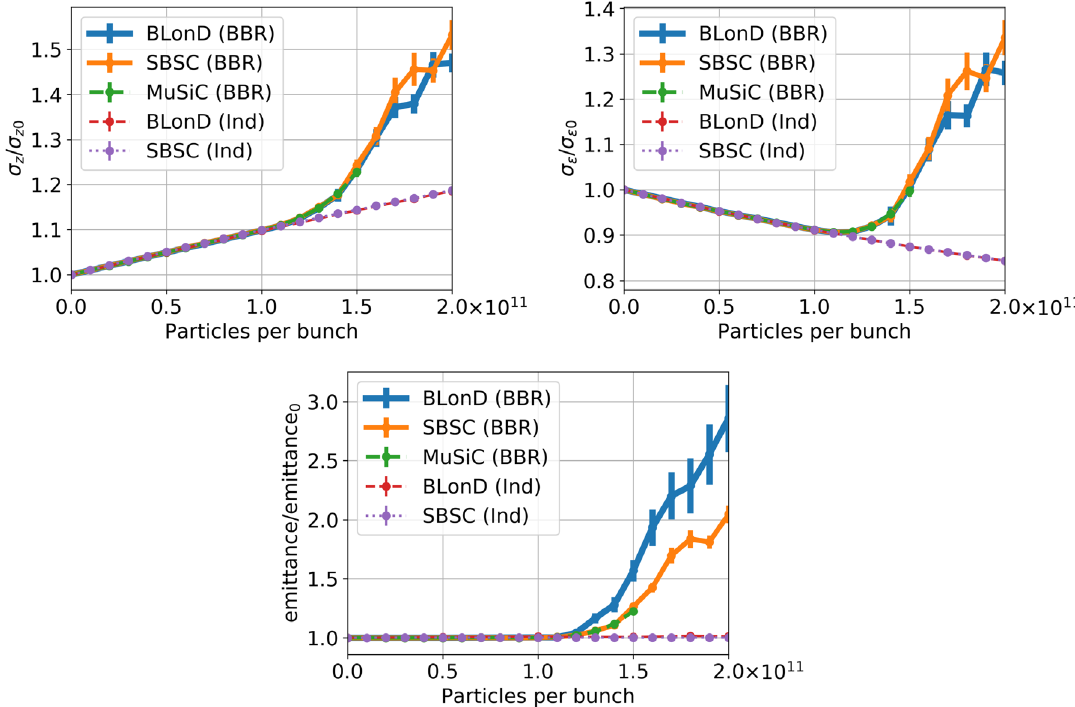
FIG. 10. Bunch length (left), energy spread (right) and emittance (bottom), normalized to their zero-intensity values, as a function of the bunch population for the BBR and pure inductive impedance obtained with different simulation